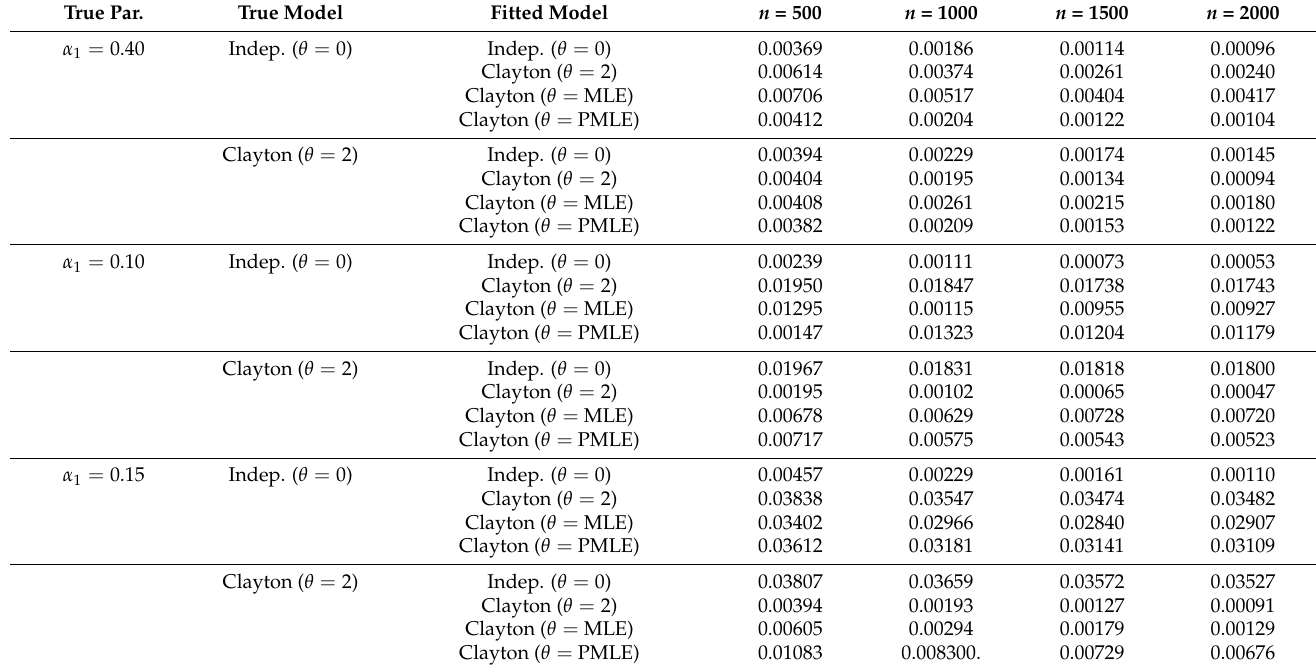
Table 3. The MSEs of the estimates of α 1 under various sample sizes n based on 1000 runs.